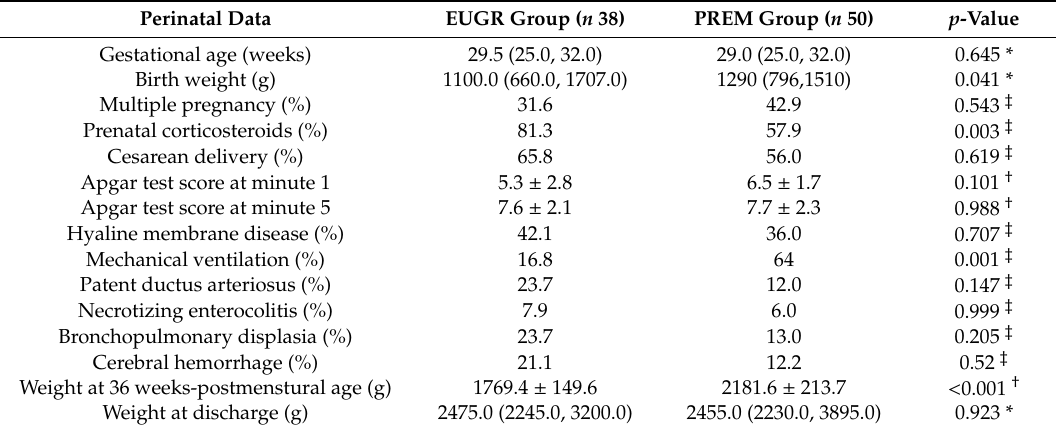
Table 1. Perinatal data of children with a history of prematurity and extrauterine growth restriction (EUGR group) and those with prematurity without EUGR (PREM group).